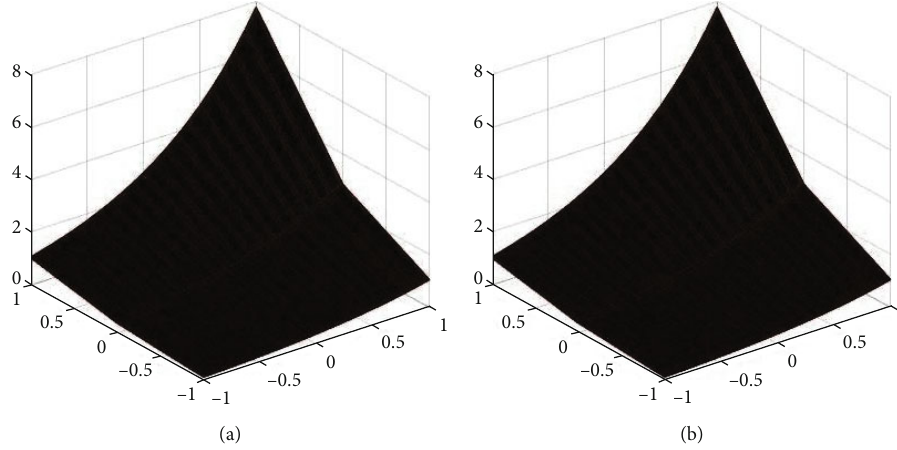
Figure 10: The di ff erent fractional-order result of ν ð χ , ξ , I Þ at δ = (a) 0 : 8 and (b) 0 : 6 of example.